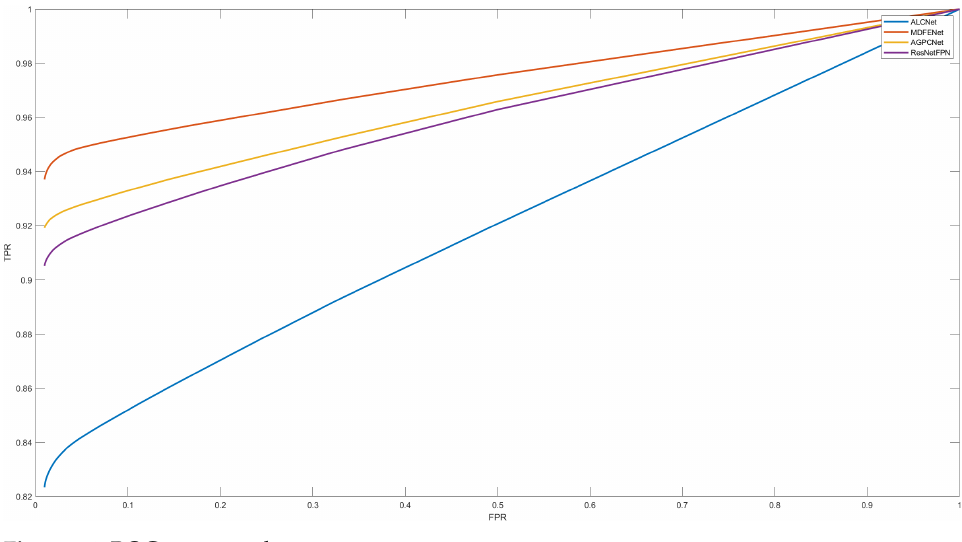
Figure 14. ROC curve on dataset. Table 4. Performance comparison results with other model- and data-driven